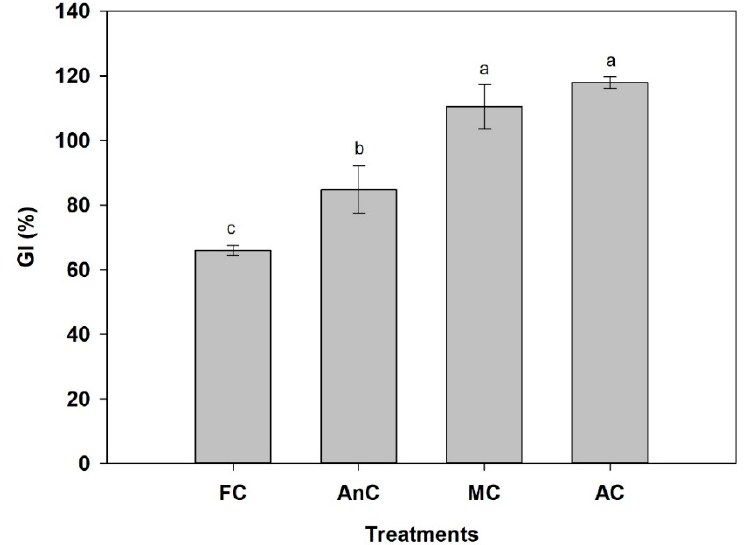
Figure 3. Germination indexes (GIs) of different composting treatments at the end of the process. FC—farmer compost; AnC—anaerobic compost; MC—mixed compost; AC—aerobic compost. Data are shown as the mean ± SD. Bars with different letters mean significant difference at p < 0.05.